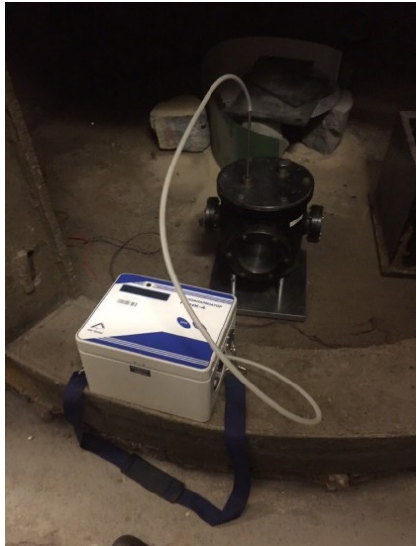
Figure 3. Scheme for measuring emissions of nitrogen oxides (photo by the author R.S. Babkin).